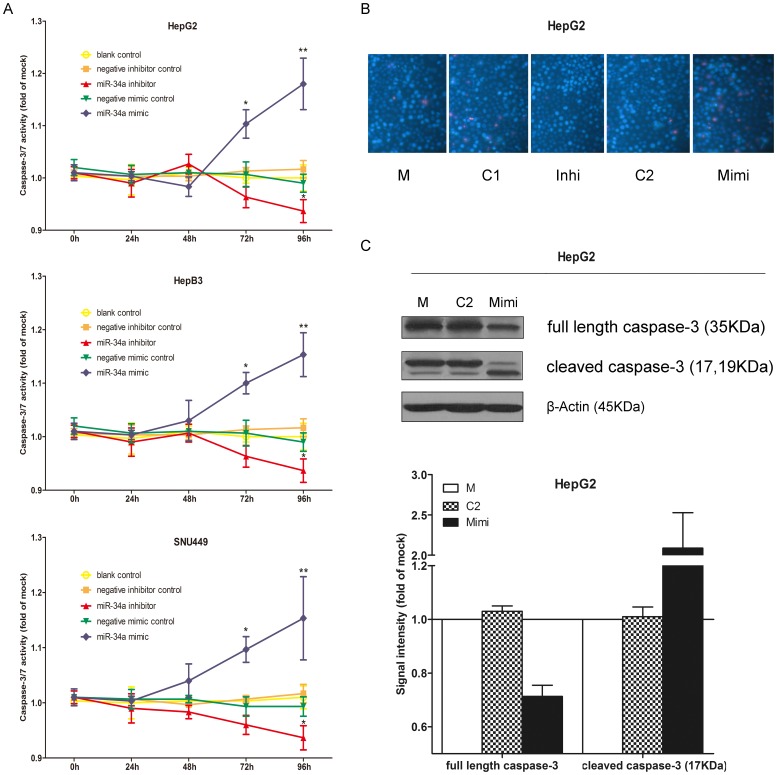
Effect of miR-34a on apoptosis in HCC cells.HepG2, HepB3 and SNU449 cells were treated as in Figure 2. (A) Caspase-3/7 activity was detected using Apo-ONE Homogeneous Caspase-3/7 Assay. * P<0.05, ** P<0.01, compared to blank and negative controls at the same time point. (B) Hoechst 33342/PI double fluorescent chromatin staining with different transfections for 96 hrs in HepG2 cells (×200). (C) Western blot and signal intensity of the bands. Cells were treated for 96 h. Antibodies include: full length caspase-3, cleaved caspase-3 and β-actin. M: mock control; C1: Negative control for miRNA inhibitor; Inhi: miR-34a inhibitor; C2: Negative control for miRNA mimic; Mimi: miR-34a mimic.